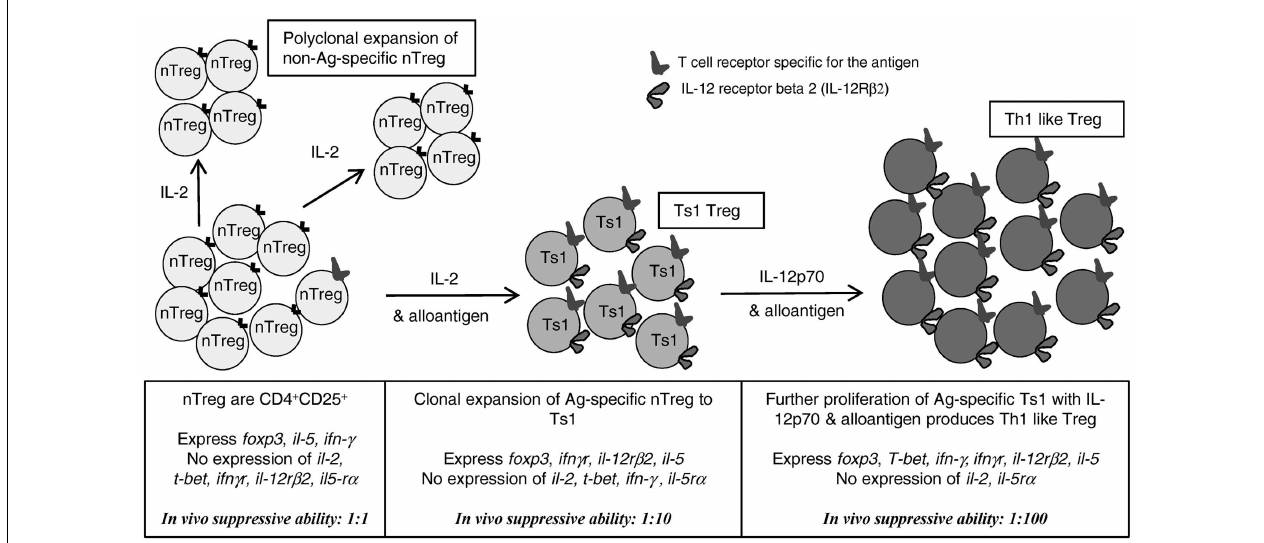
retain theTs1 phenotype, but in addition express t-bet and ifn- γ and no il-2 . These have enhanced capacity to suppress in vitro and in vivo at lower ratios to effector CD4 + T cells, than nTreg (1:100 vs. 1:1) andTs1 [1:100 vs. 1:10 (2)]. Thus, inflammatoryTh1 cytokines drive induction of alloantigen-specificTreg; the first step is induction of alloantigen-specificTs1 cells by the earlyTh1 cytokine IL-2; the second step is induced by rIL-12p70 only after IL-2 production wanes. rIL-12p70 inducesTh1-likeTreg that express both t-bet and foxp3 as well as ifn- γ , ifngr , and il-5 . Adapted from Figure 1 in Hall et al.